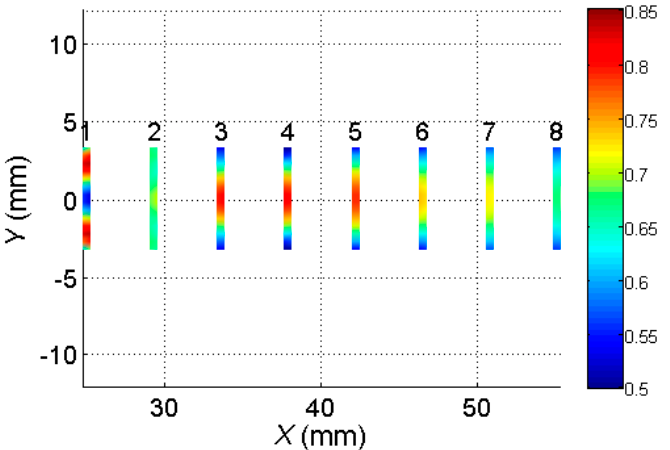
Figure 5. Spatial distribution of maximum normal displacement amplitudes of virtual receiving elements 1–8. The color bar shows the amplitudes ( μ m) of the normal displacements.